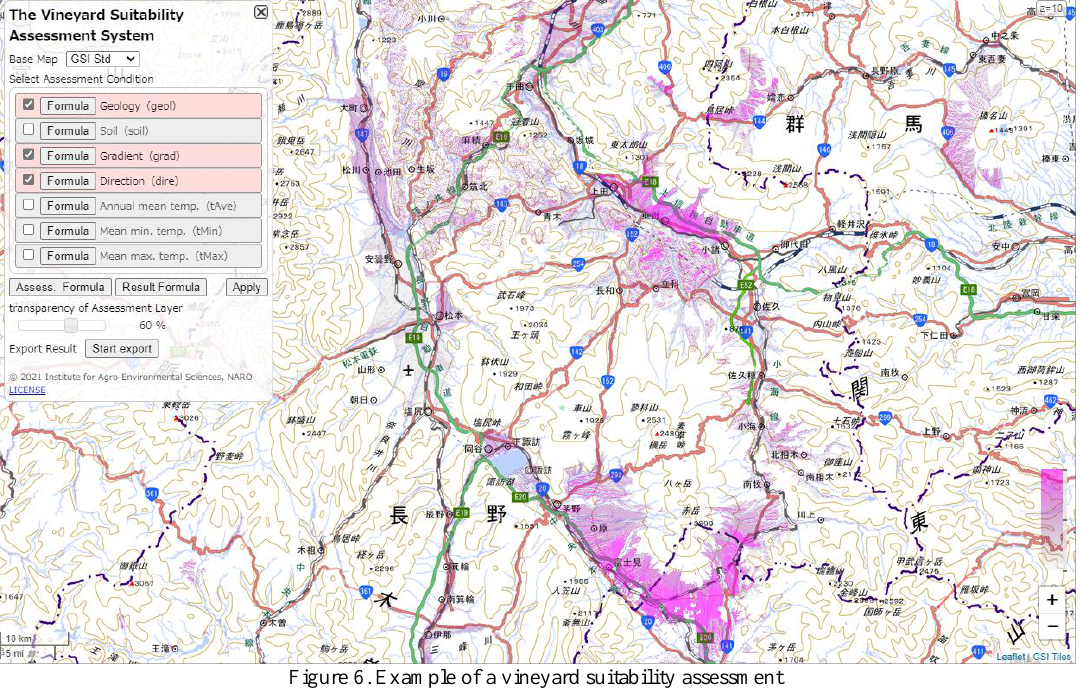
Figure 6. Example of a vineyard suitability assessment